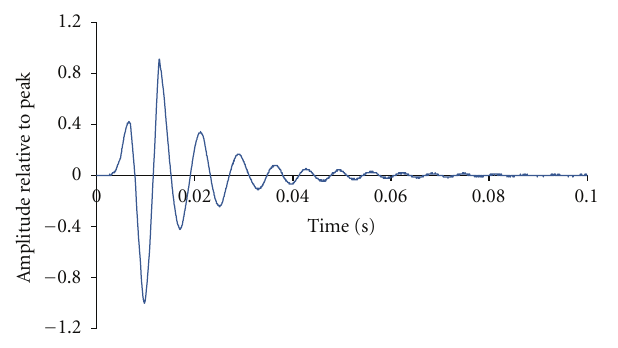
Figure 4: Selected haptic feedback e ff ect waveform.